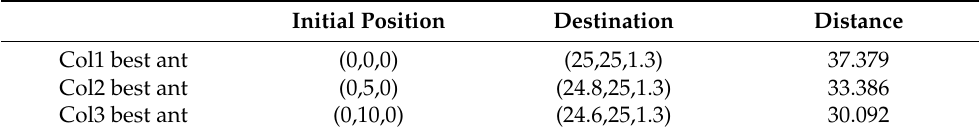
Table 3. Flight Details of Best Ants of Each Colony for Case I.